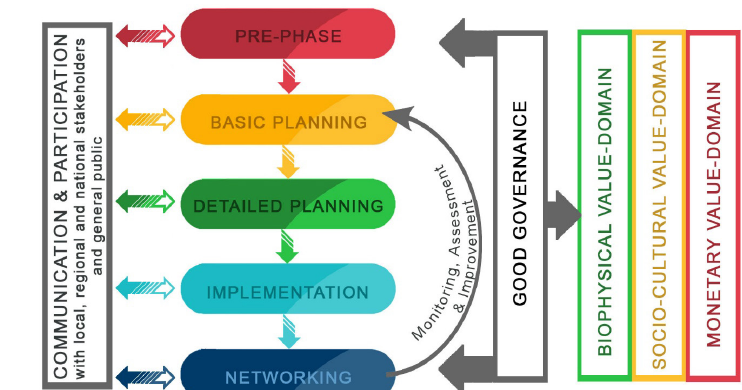
Figure 5. Gradation model of integrated protected area management and diagnostic of IPAM framework. The conceptual framework focusses on the interactive processes between social, cultural, ecological and economic subsystems. There are more specific components that are nested within the phases of each subsystem, but they are not shown here (source: authors’ own draft)